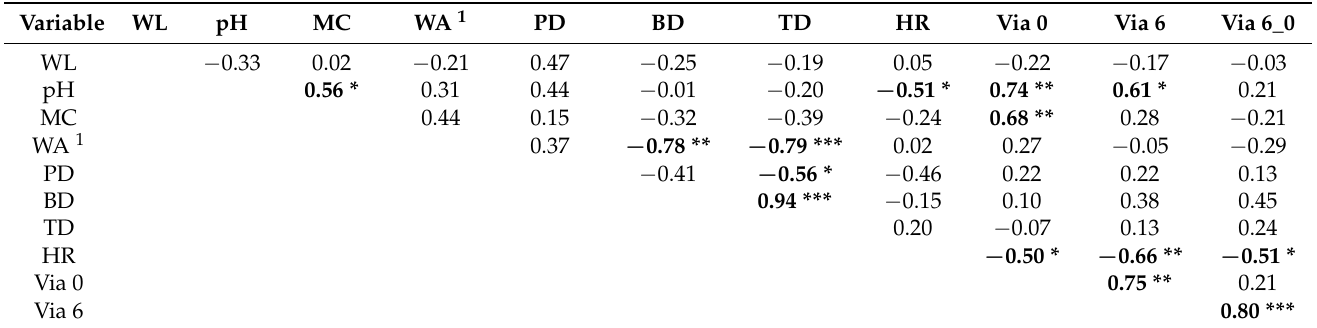
Table 3. Correlation matrix of selected variables: Pearson’s correlation coefficients, significant correlation indicated in